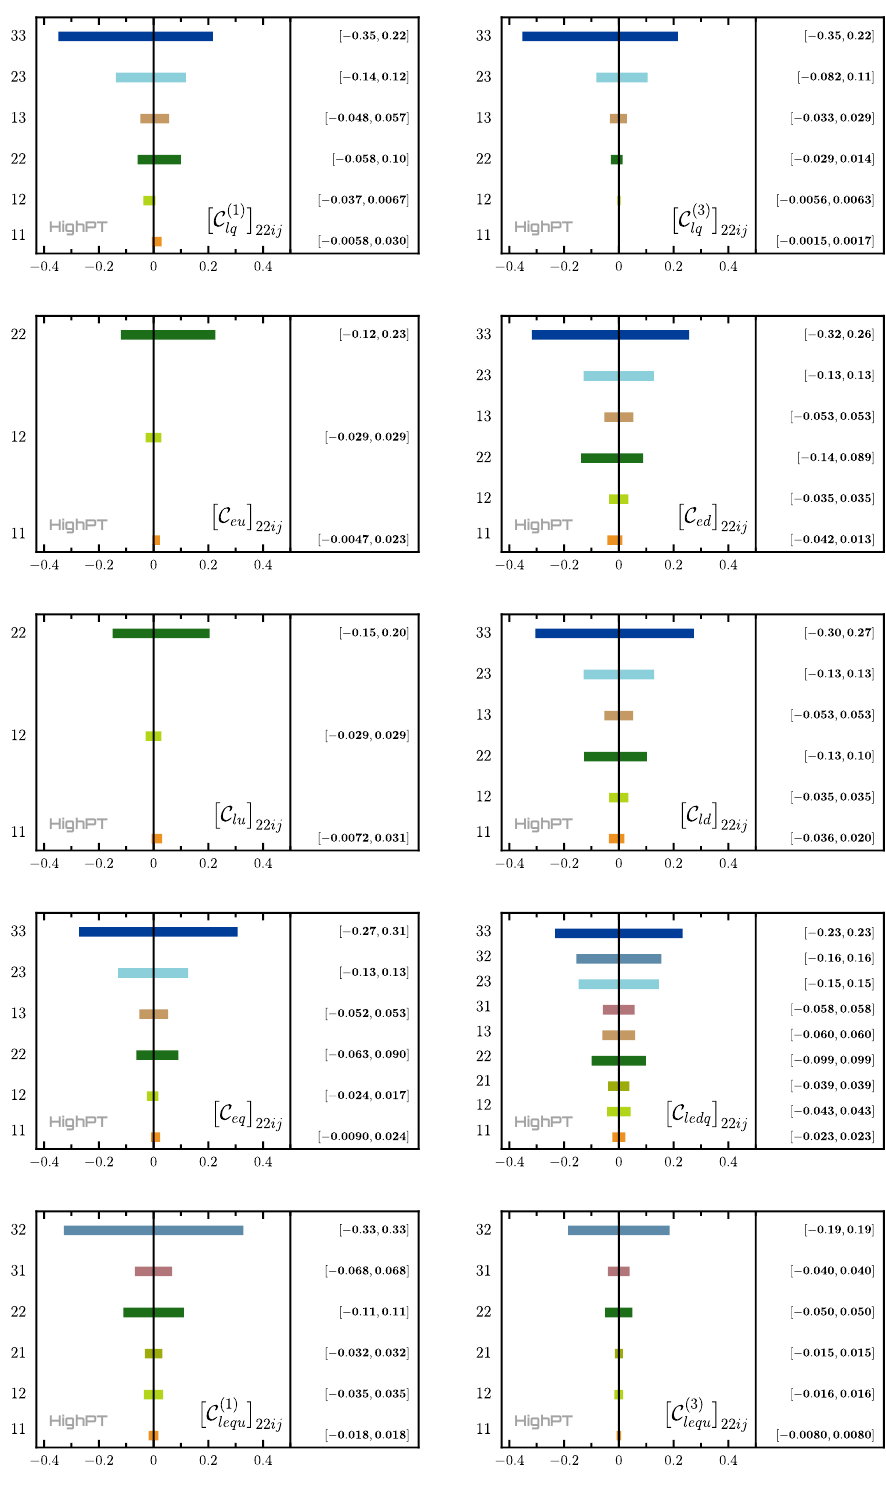
Figure 15. LHC constraints on semileptonic d = 6 Wilson coefficients with µµ flavor indices to 95% CL accuracy, where a single coefficient is turned on at a time. See caption of figure